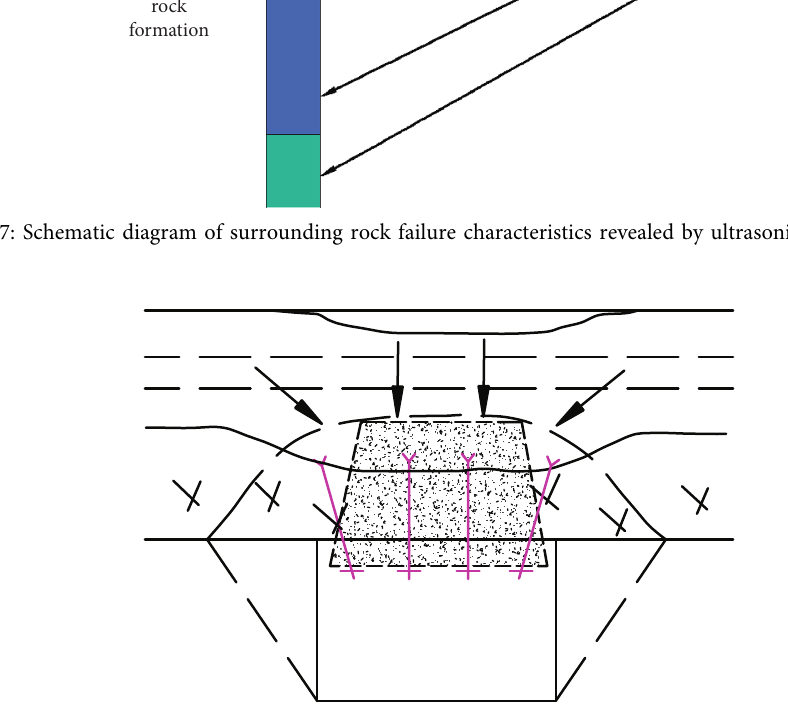
Figure 18: Schematic diagram of the instability of roof rock layer under original anchor